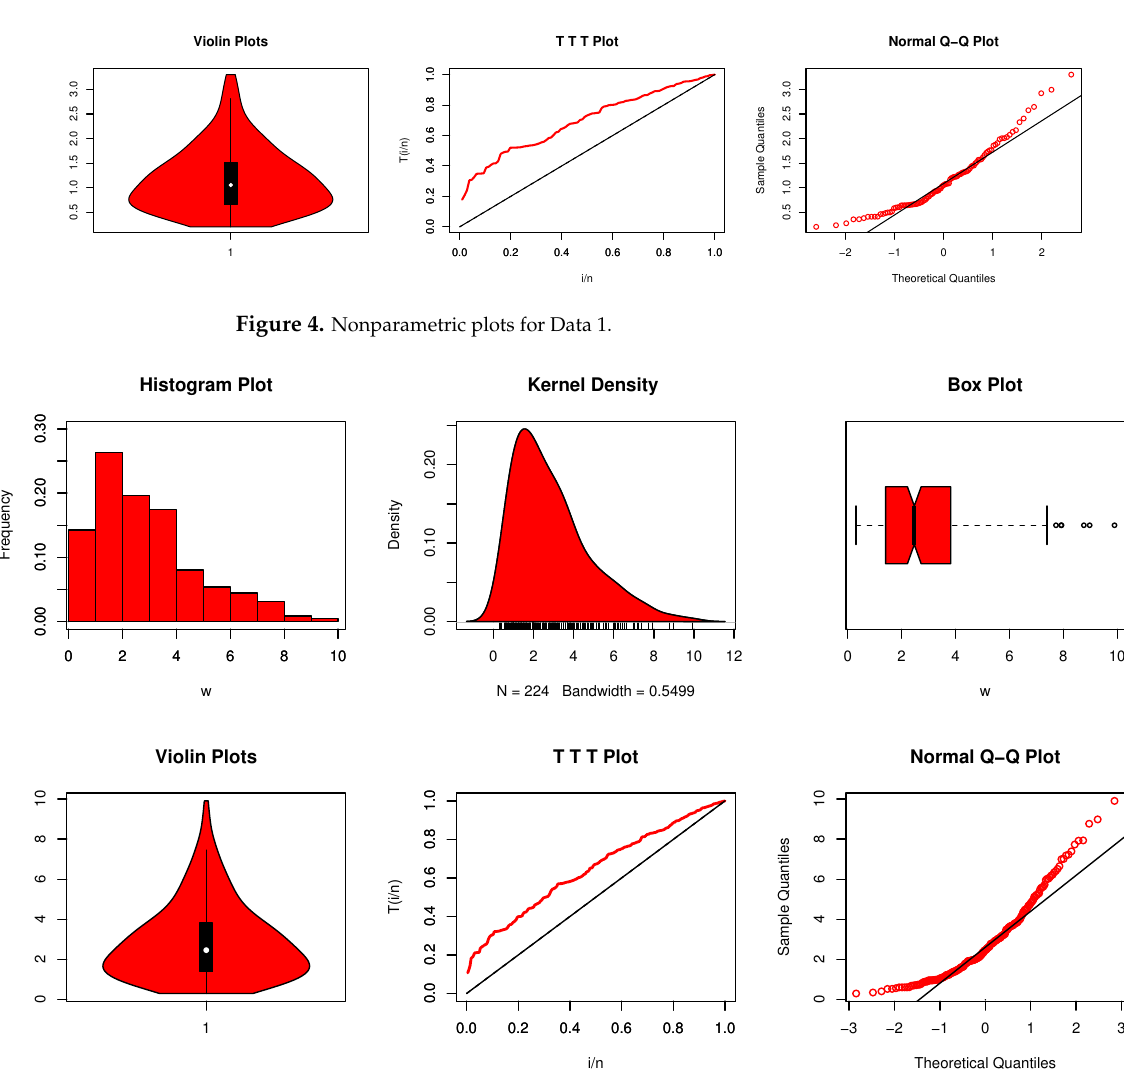
Figure 5. Nonparametric plots for Data